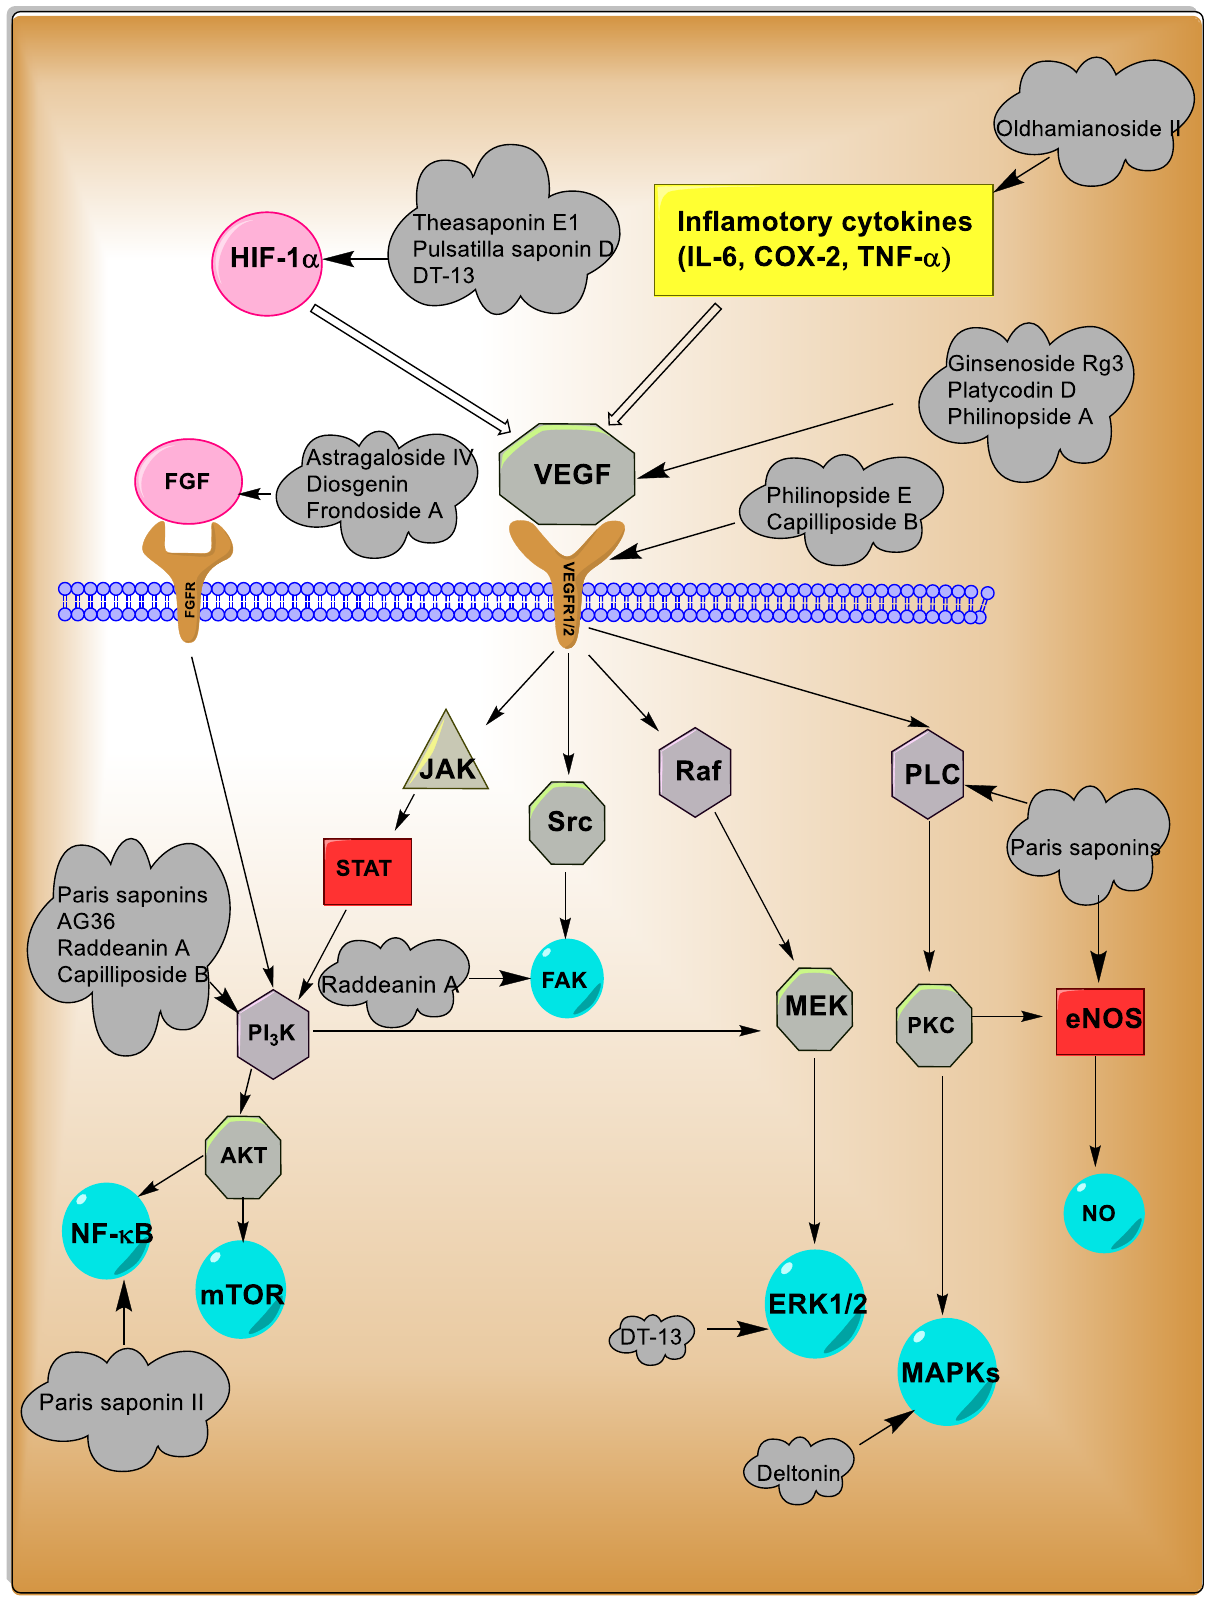
Figure 6. Anti-angiogenesis mechanisms of saponins.